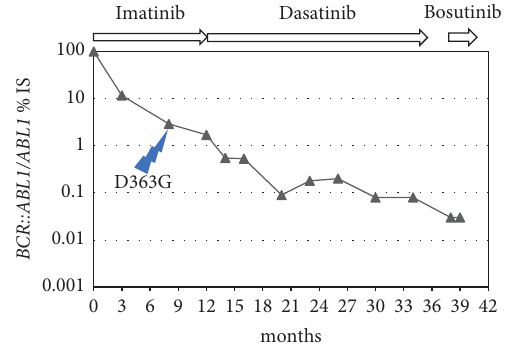
Figure 1: Te peripheral blood BCR-ABL1 transcript level throughout the disease course. IS: international 2.9% (Figure 1) prompting the BCR::ABL1 KDM analysis by NGS of cDNA [2] that revealed a D363G mutation (c.1088A > G, p.Asp363Gly, and NM_005157.6) present in 22% of expressed BCR::ABL1 transcripts. Unfortunately, no pretreatment RNA remained for the BCR::ABL1 KDM mutation analysis. At twelve months, the BCR::ABL1 transcript level was 1.7% representing imatinib failure [8].